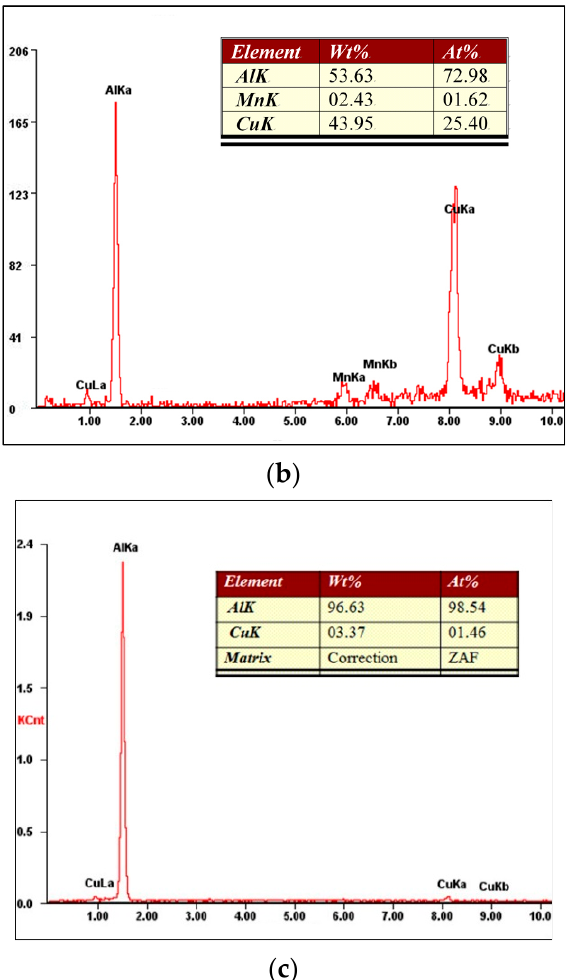
Figure 5. The phase components detected by energy dispersive spectrometer: ( a ) Point A (Al 2 Cu);